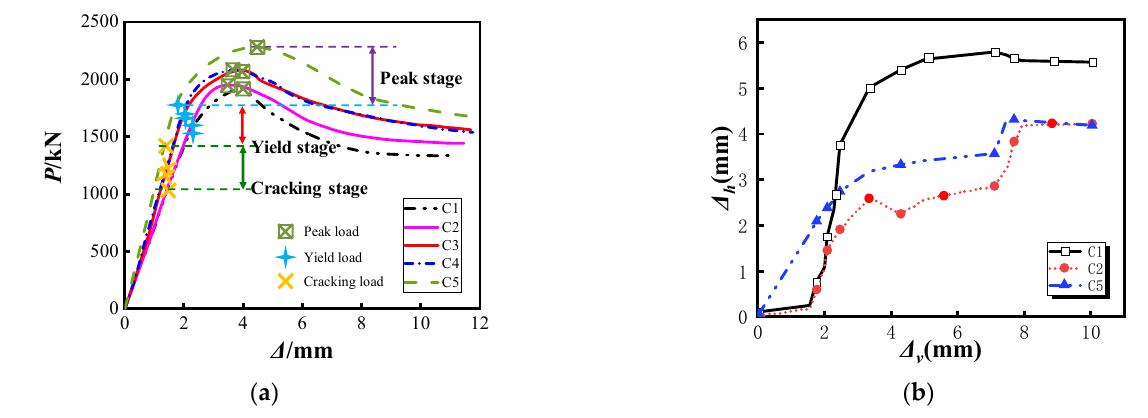
Figure 9. Specimen load–displacement curve and transverse deformation. ( a ) Load–displacement curve ( b ) Steel tube deformation comparison diagram. Table 4. Load–displacement